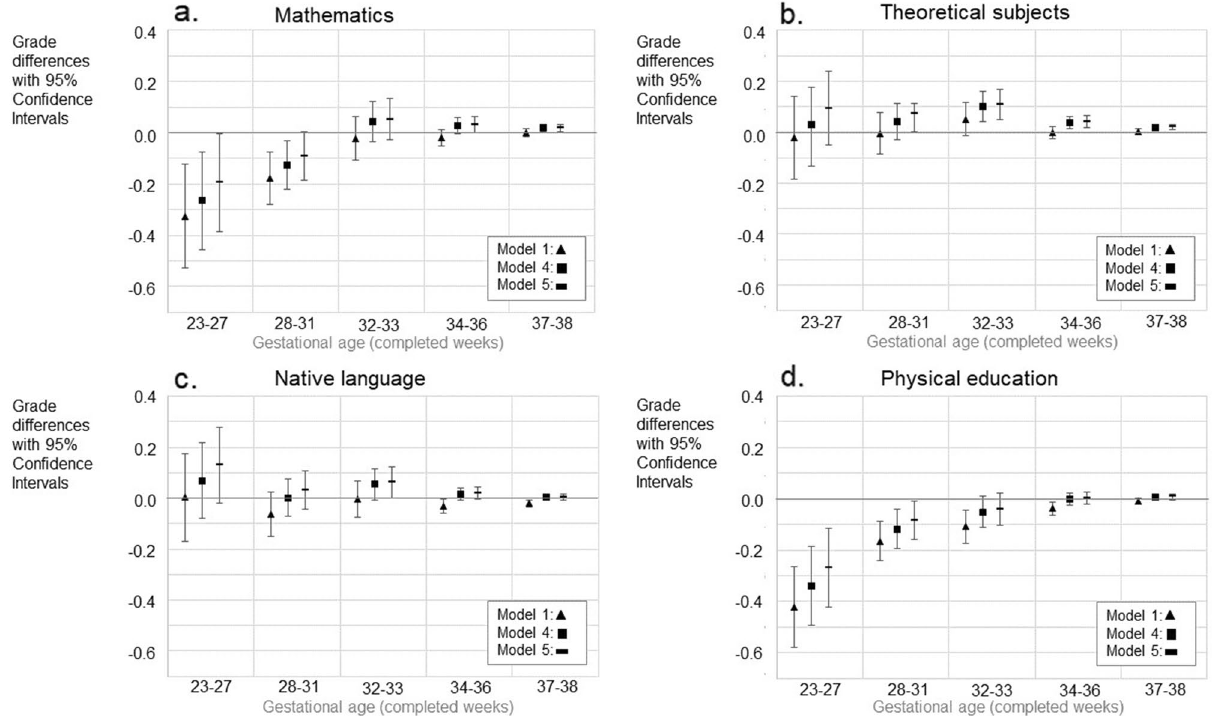
Figure 3. Differences in school grades ( a–d ) in mainstream education with 95% confidence intervals (CIs). The figures show models 1, 4, and 5. Models 2 and 3 are available in the Supplementary Tables 5–8. GA category 39–41 weeks is the reference group (with grade difference 0.0). Only such individuals who attended mainstream education in compulsory education are included. Model 1; Unadjusted model, Model 4; Adjusted for the sex, birth year, maternal and paternal ages, maternal and paternal highest attained education, BWSDS, gestational disorder(s), maternal smoking at pregnancy, maternal marital status at the childbirth, and birth order, Model 5; Adjusted as Model 4, and for severe medical Grades at the end of compulsory school. Figure 3 and Supplementary Tables S5–S8 illustrate the grades (as grade differences in points and as z-scores) on mathematics, theoretical subjects, native language, and physical education in mainstream education by GA. In fully adjusted model those born extremely preterm had 0.2 (SD − 0.4 to 0.0) points lower mathematics grades than those born full-term, whilst those born late preterm or early term had in fully adjusted model slightly higher grades; 0.03 (SD 0.00–0.06) points and 0.02 (SD 0.00–0.03) points respectively. Very-, moderately- and early preterm births, as well as early term births were associated with marginally higher grades in theoretical subjects in fully adjusted models: (0.07 (SD 0.00–0.11)